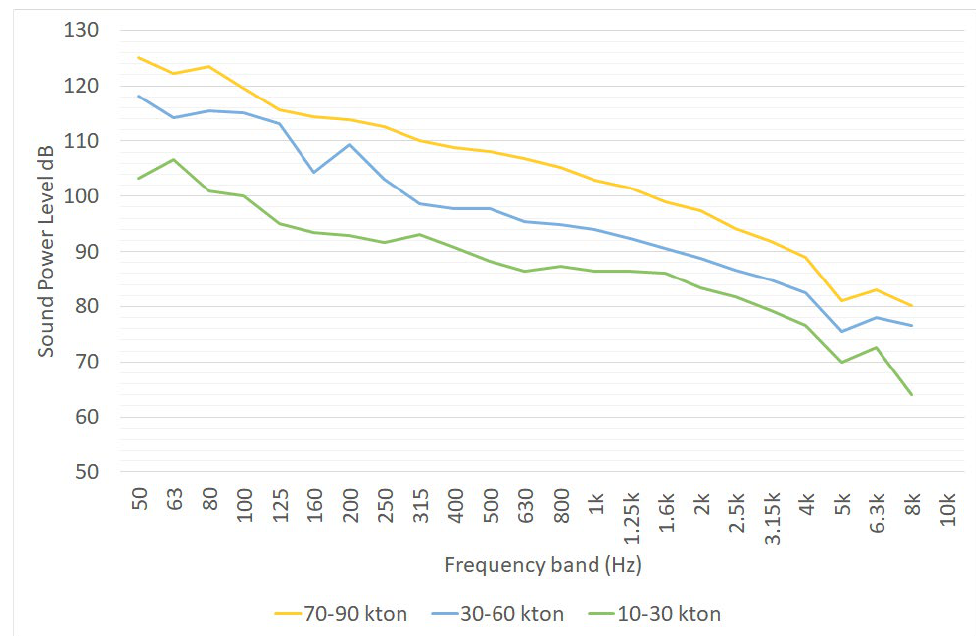
Figure 10. One-third octave sound power spectra of cruise ships divided into big (70 to 90 ktons), medium (30 to 60 ktons) and small size (10 to 30 ktons), as reported in [24]. L W is expressed in dB for point sources, in dB/m for linear sources and in dB/m 2 for area sources. Table 7. Noise emission data of moored ship, as reported in [27]. * TEU: twenty-foot equivalent unit.